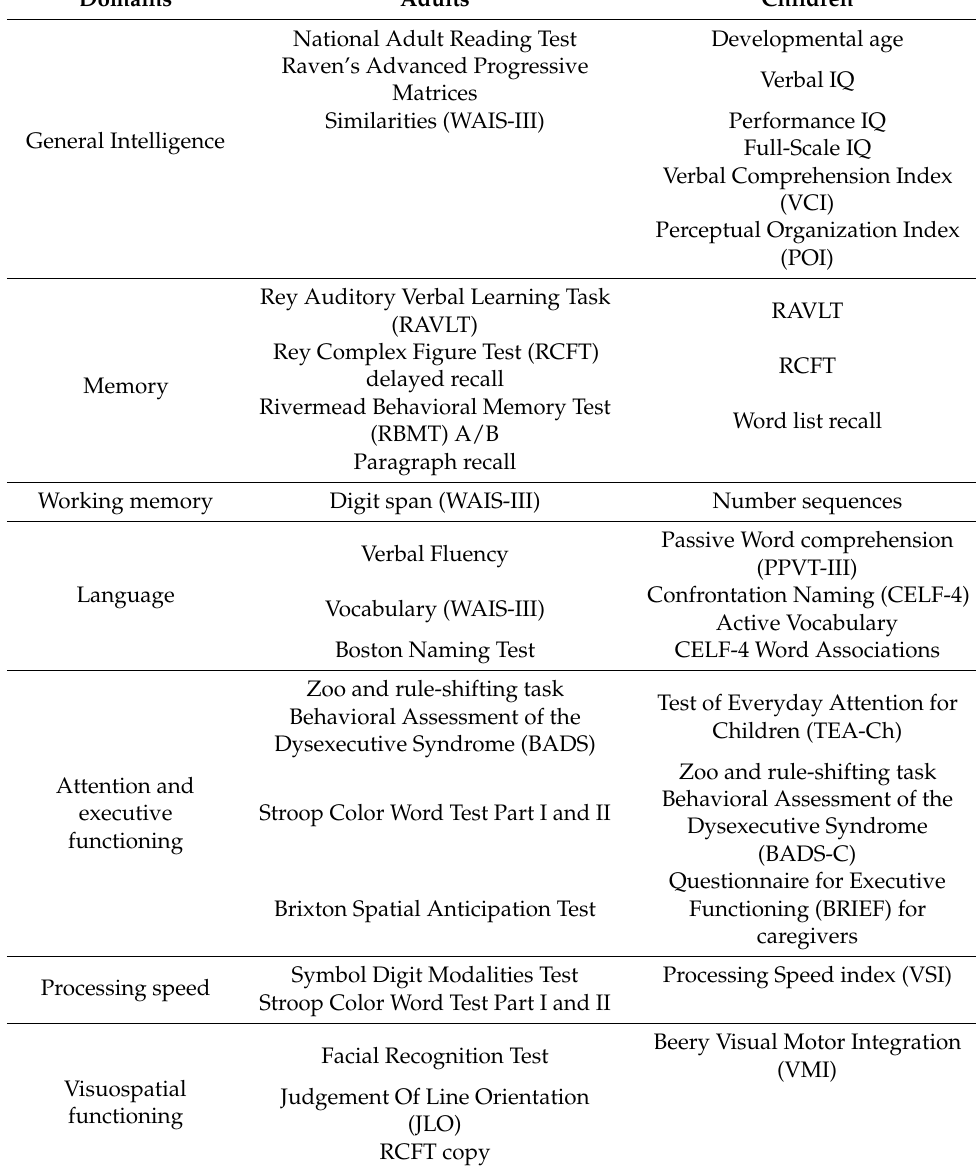
Table A1. Neuropsychological tests applied in adults and children and the grouping of tests in cognitive domains according to Lezak, as described previously